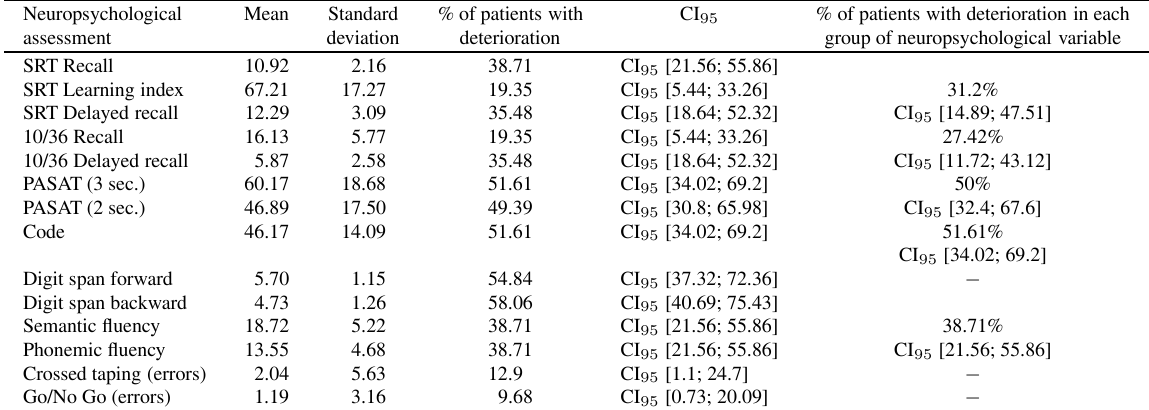
Table 1 Scores to neuropsychological tests (means and standard deviations) and proportions of deteriorated patients with the 95% con fi dence interval (CI 95 ) of this proportion [37]. In the last column, some cognitive score have been grouped for comparison with EEG data. Means of proportion of deteriorated patients for each group of cognitive variables are presented. PASAT: paced auditory serial task. SRT: selective reminding task.